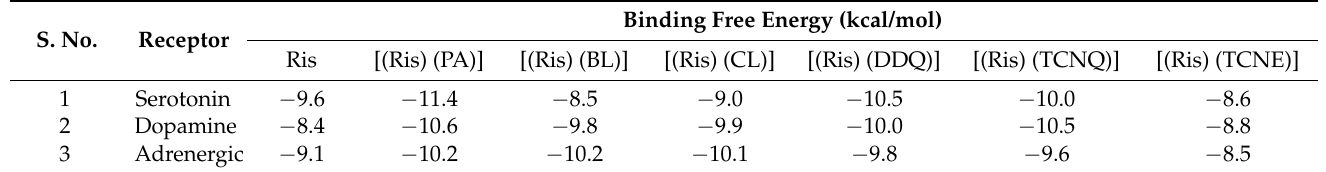
Table 1. Docking scores of six synthesized CT complexes with three receptors.